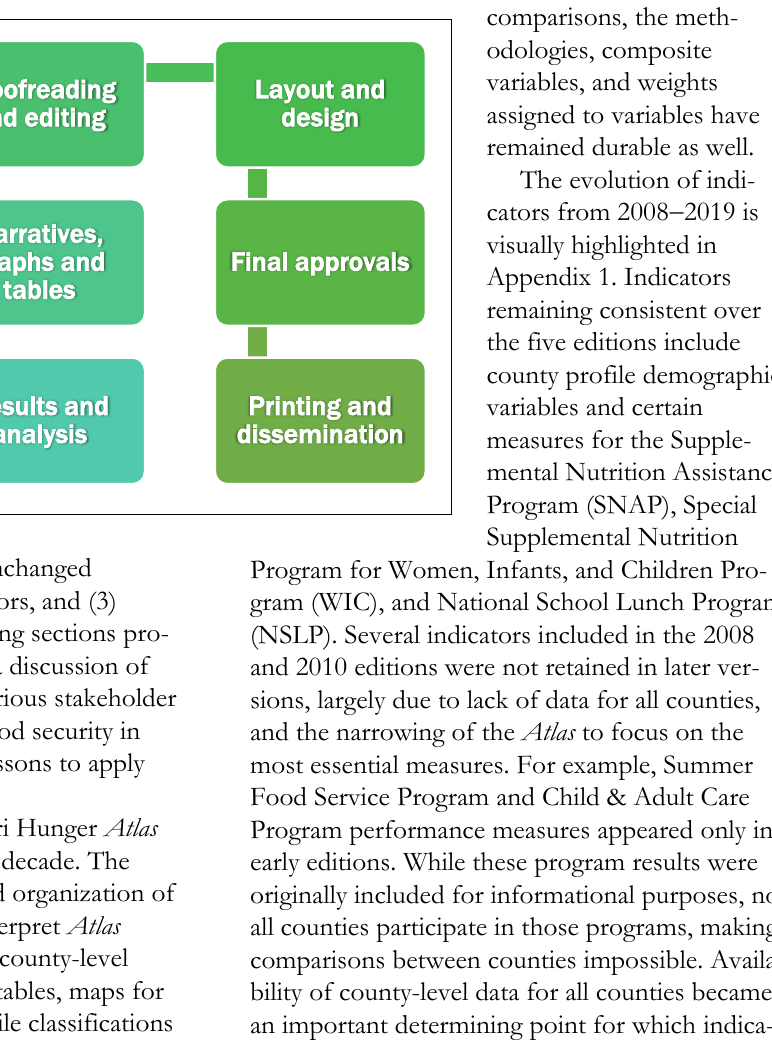
Figure 5. Stages in Constructing the Missouri Hunger Atlas